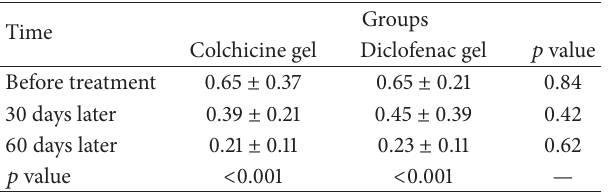
Table 2: Mean ( ± SD) of surface of lesion: before and after the